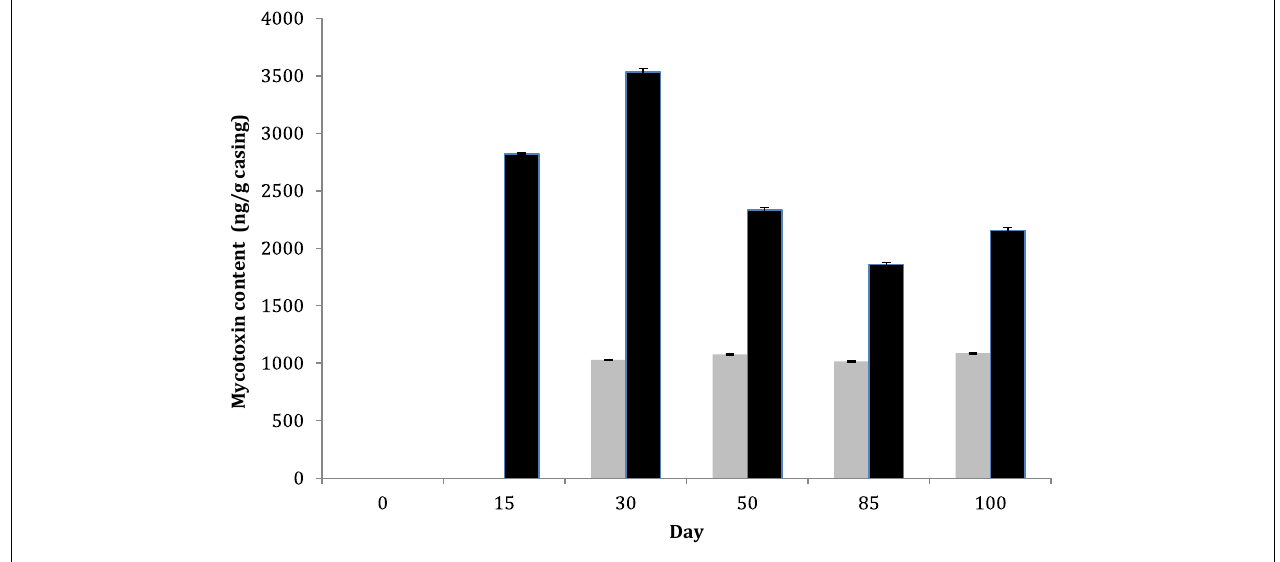
FIGURE 5 | Mycotoxin content during pilot-scale fermented sausage productions using challenge tests after inoculation of two P. nordicum isolates on collagen (black) and natural chaudin (gray) casings. No mycotoxins were produced by P. nalgiovense and therefore omitted from the